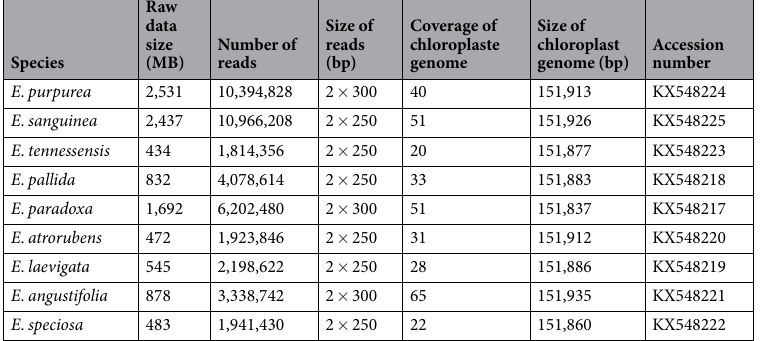
Table 1. The nine species sampled in this study and information on the chloroplast genome assembly.